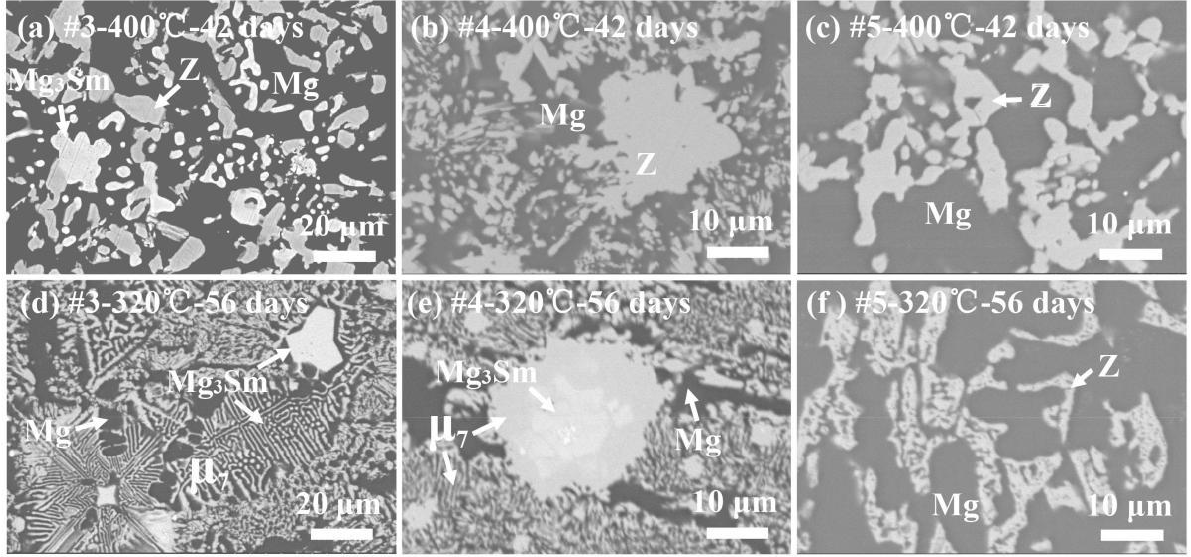
Figure 5. The BSE images of alloys #3 – #5 ( a – c ) annealed at 400 °C for 42 days and ( d – f ) annealed at 320 °C for 56 days.